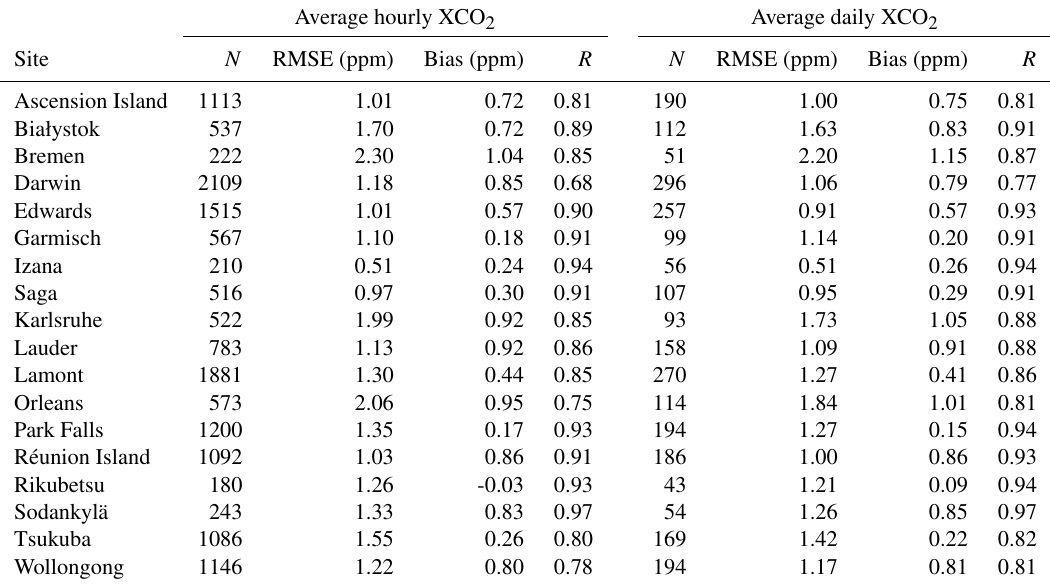
Table 8. Statistics for the average hourly XCO 2 and average daily XCO 2 comparison between TCCON measurements and MPAS-A simu- lations: RMSE (ppm), bias (ppm), and correlation coefficient R . N is the number of data pairs used for computing the statistics. Average hourly XCO 2 Average daily XCO 2